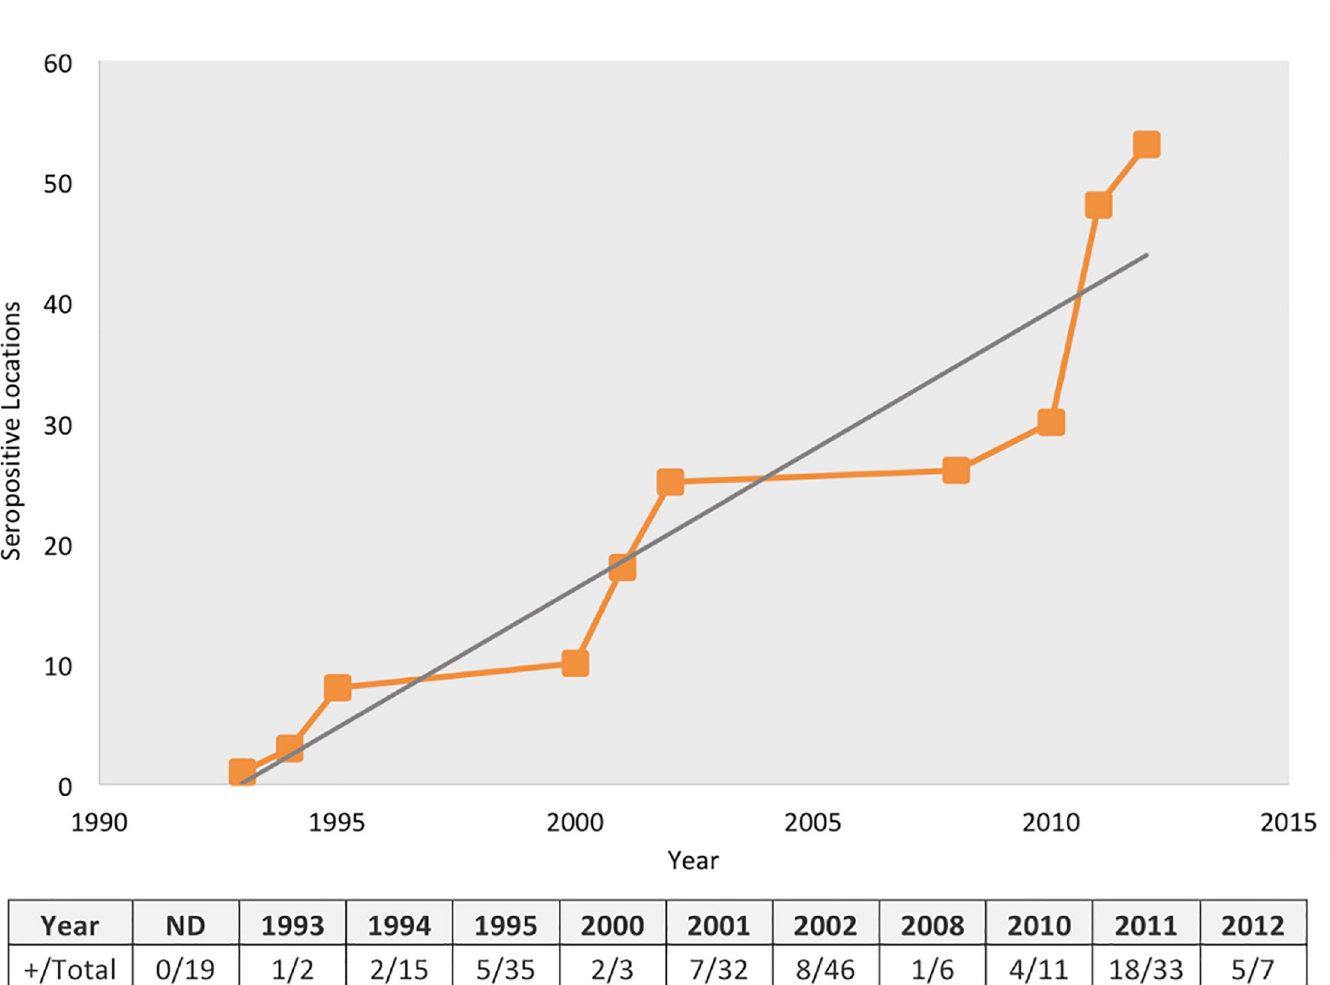
Fig 1. Cumulative curve of locations with seropositive wild non-human primates to flavivirus over time. ND: year not determined.